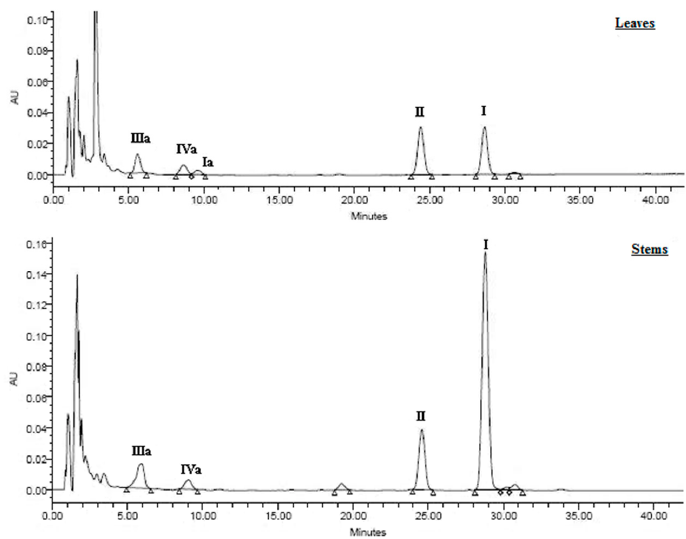
Figure 3. Representative chromatograms of leaves and stems aristolochic acids from Aristolochia chilensis .